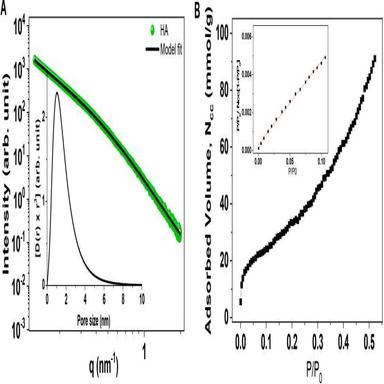
(A) SAXS profile of nanoporous HA microparticles. The solid line depicts the fitting of the polydisperse spheres model to the experimental data. The inset shows the estimated pore size distribution. (B) N2 adsorption isotherm of nanoporous HA microparticles. Inset shows the BET linear fit used for estimation of the specific surface area.